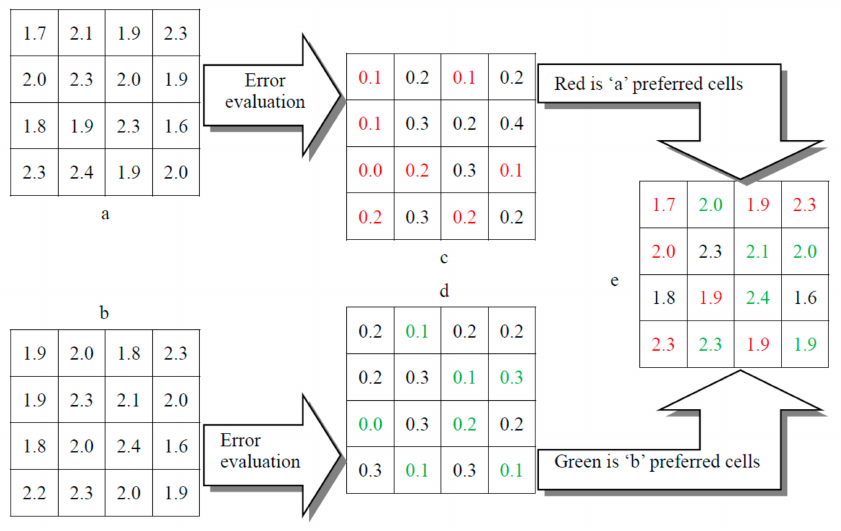
Figure 8. The raster cell optimization process (‘a’ and ‘b’ are different models of raster interpolation, ‘c’ and ‘d’ are the interpolation error, ‘e’ is the optimal raster cell mosaic